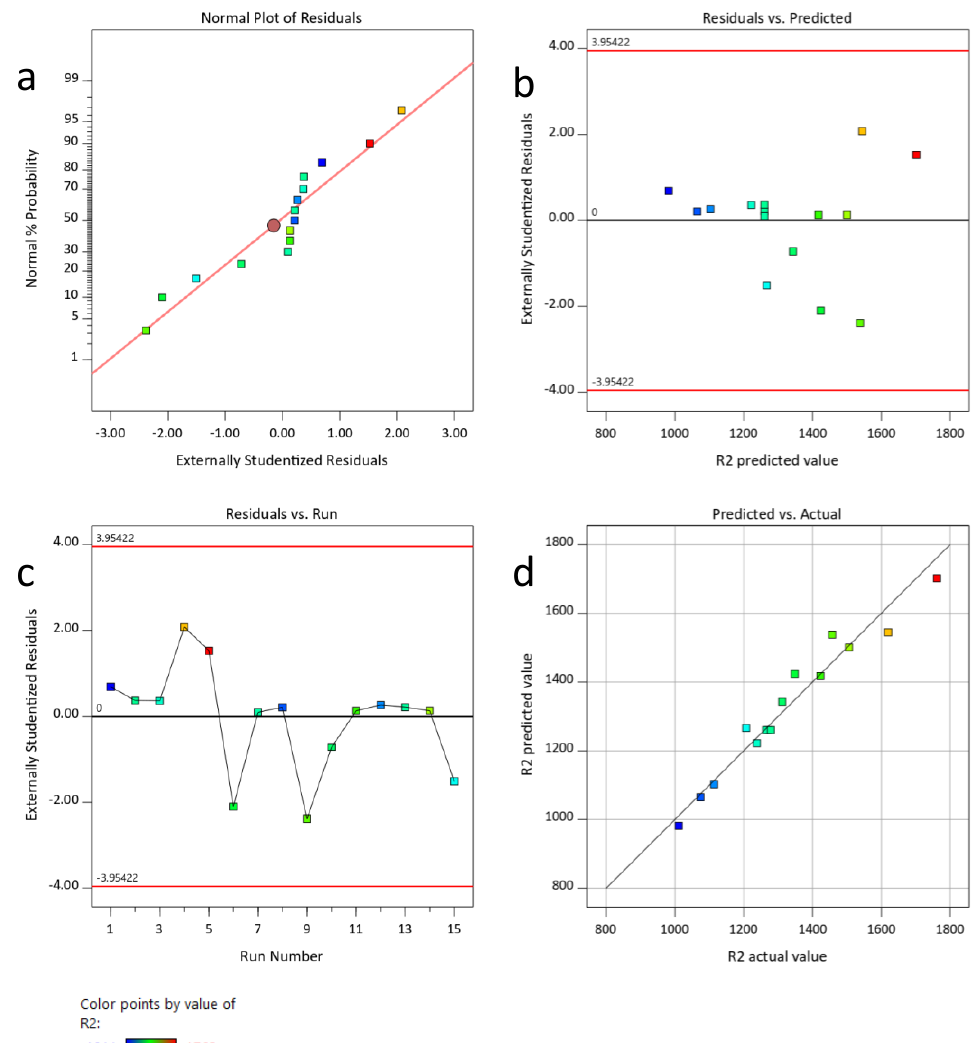
Figure 3. Model diagnostics for response variable R 2 ( a ) A normal probability plot of the residuals; ( b ) Residuals versus predicted value of R 2 ; ( c ) Residuals versus run number; ( d ) Predicted versus actual value of response variable R 2 . Points on graphs correspond to results of particular experiments and colour points correspond to the value in accordance with the scale.